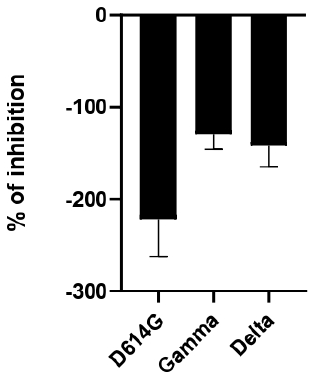
Figure 5. Antiviral activity of Saussurea costus aqueous extract against SARS-CoV-2. HEK − 293T ACE2 cells were infected with the corresponding Spike-pseudotyped virus in the presence and absence of the extract. After 24 h, the luciferase activity was measured. The % of inhibition was determined as the ratio between treated and untreated cells.